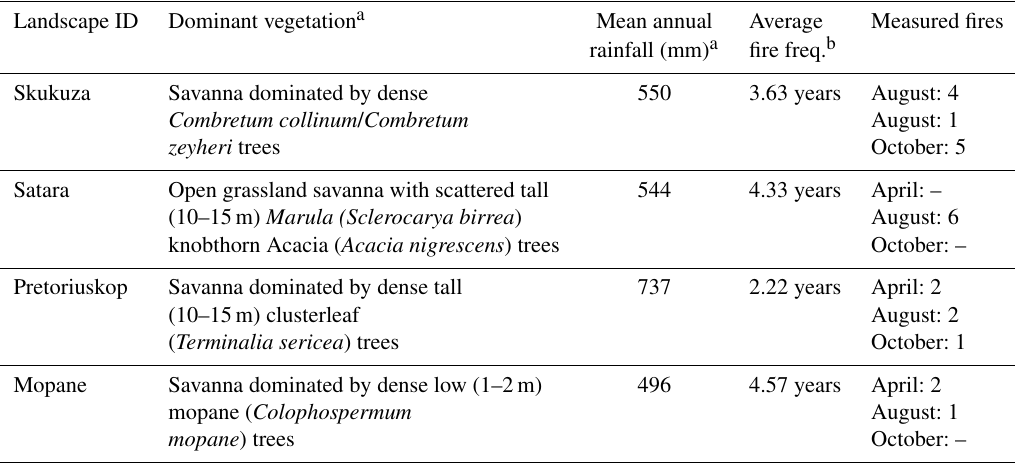
Table 2. Description of the dominant vegetation and relevant characteristics for the experimental sites. Landscape